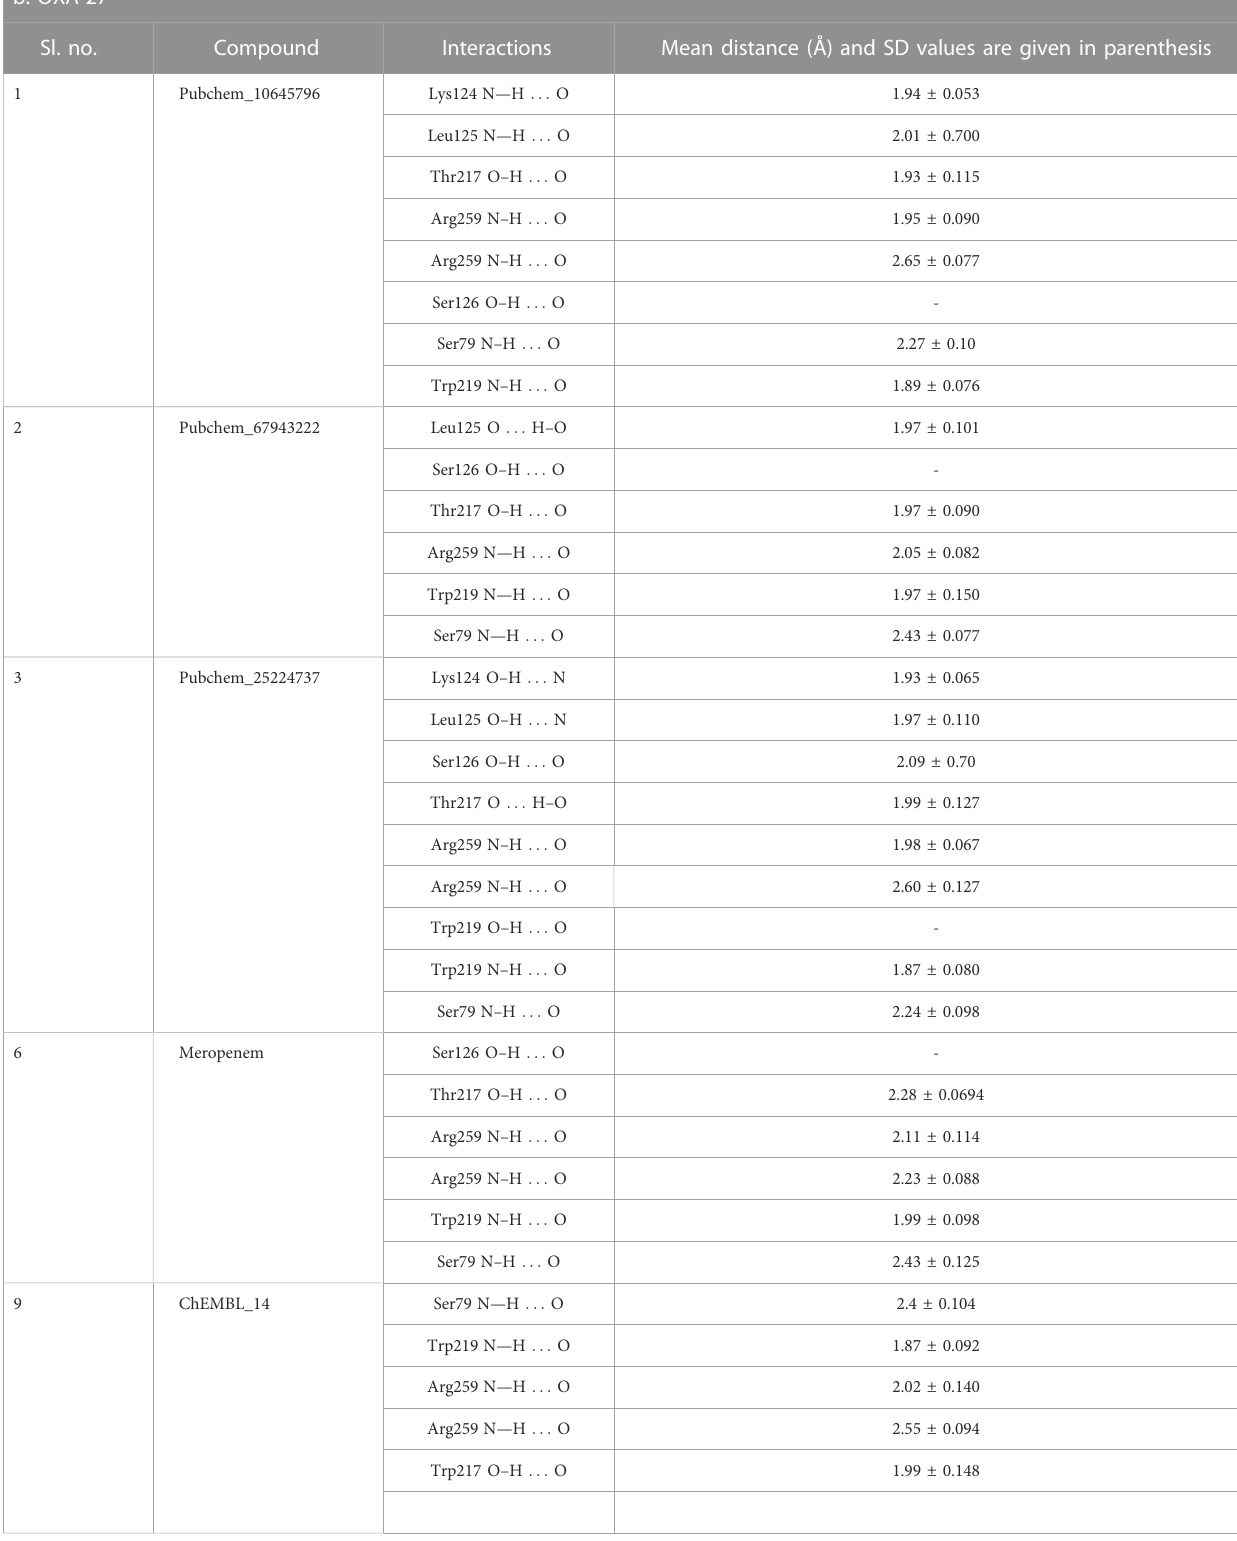
TABLE 4 ( Continued ) Top compounds from the outcome of covalent docking against OXA-23 and OXA-27. b.